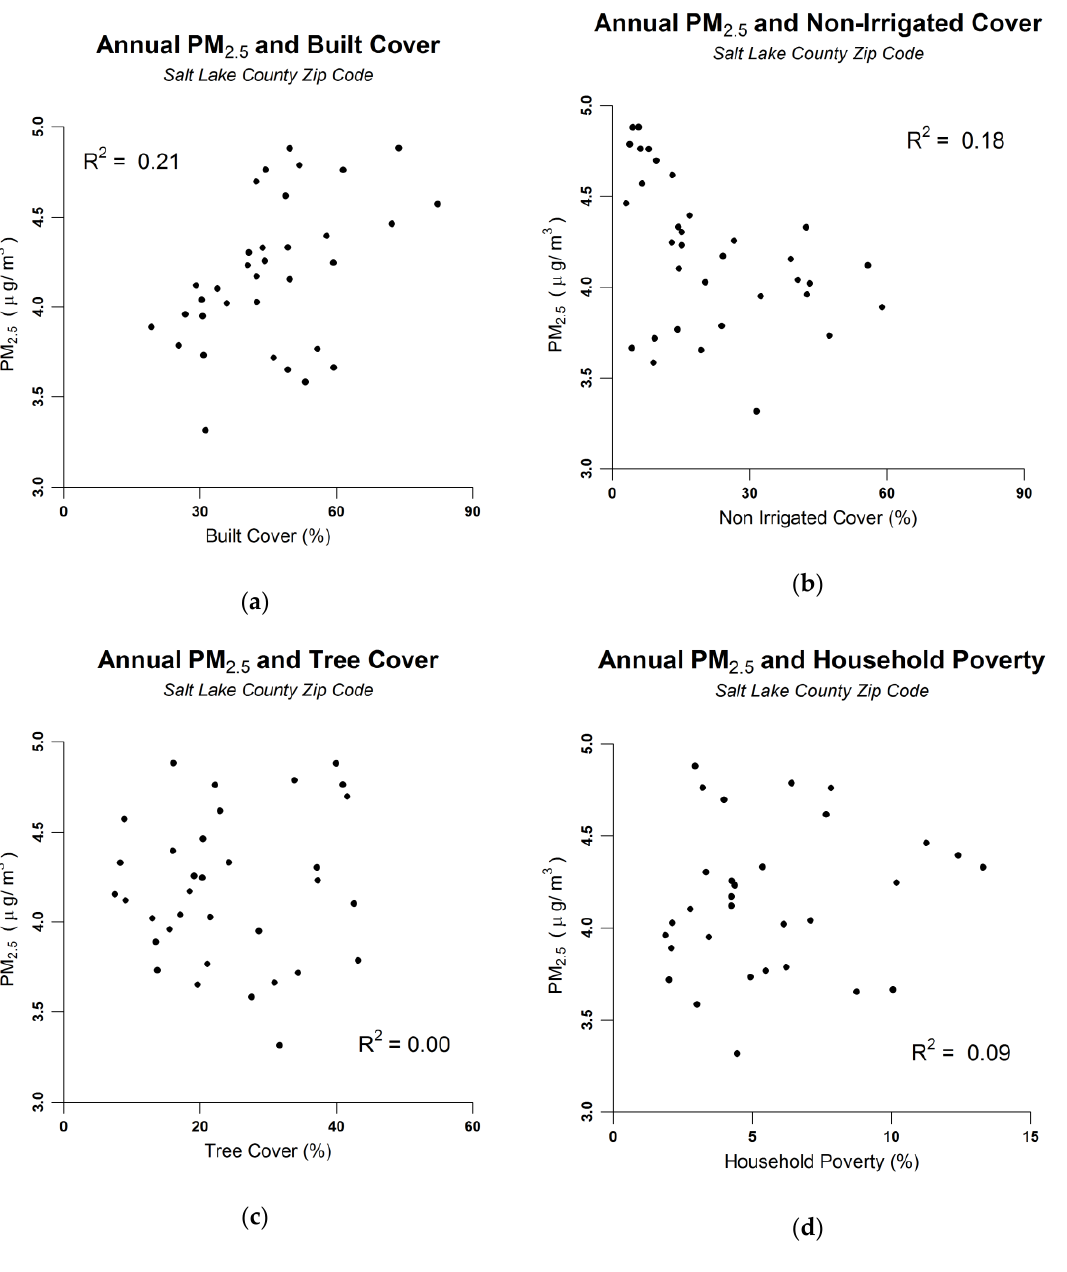
Figure 5. Annual mean PM 2.5 concentration and land cover types and sociodemographic variables at the zip code level: ( a ) Built cover; ( b ) Non-irrigated cover; ( c ) Tree cover; and ( d ) Percent of households living below the poverty line.